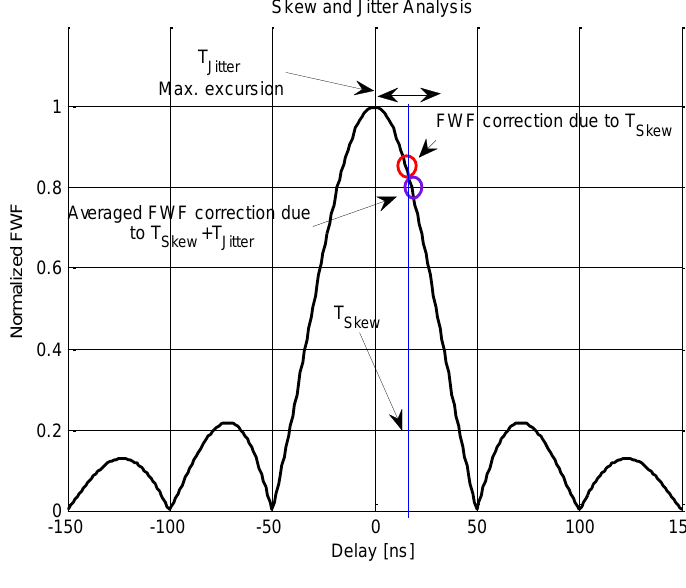
Figure 11. Impact of the clock inaccuracies on the correlation value. T rate offset between x and y , and T